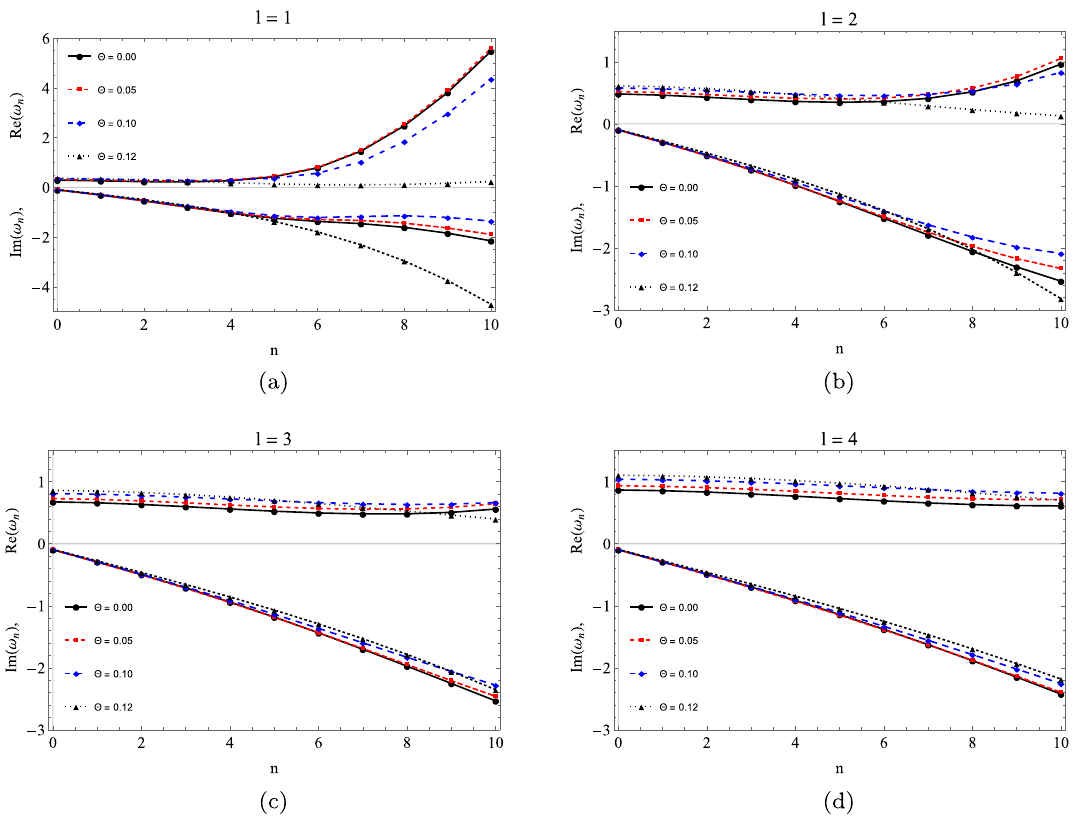
Figure 3. Real (top) and imaginary (bottom) parts of the quasinormal frequencies as function of the n . We see that for l = 1 the frequency curves are very dispersed with the increase of n , while for l = 3, 4 the curves of the real part of the frequency are more